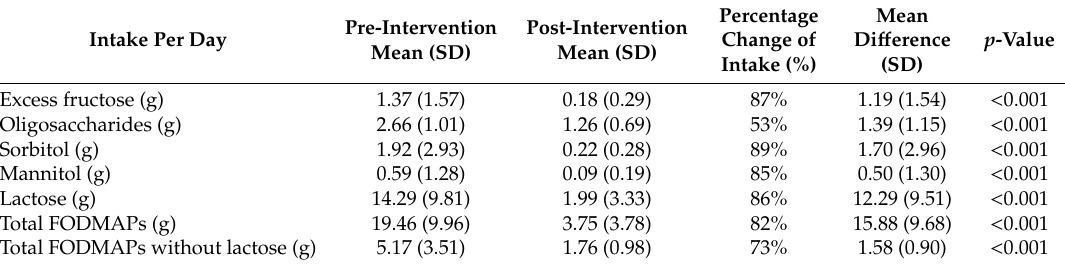
Table 3. Mean daily fermentable oligosaccharides, disaccharides, monosaccharides, and polyols (FODMAP) intake for each FODMAP group and totals at baseline and follow-up appointment. Comparisons were made by two-tailed paired samples t -test. Data shown represents the percentage change, mean di ff erence and SD.